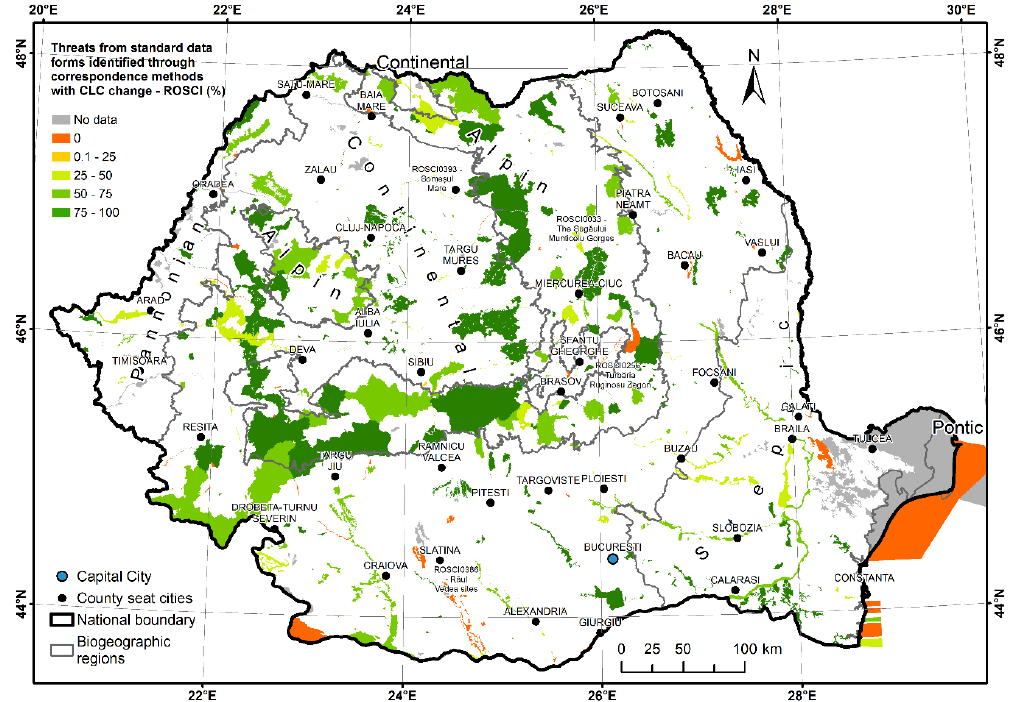
Figure 18. Distribution of threats from standard data forms, identified through correspondence methods with CLC changes (for ROSCI sites).